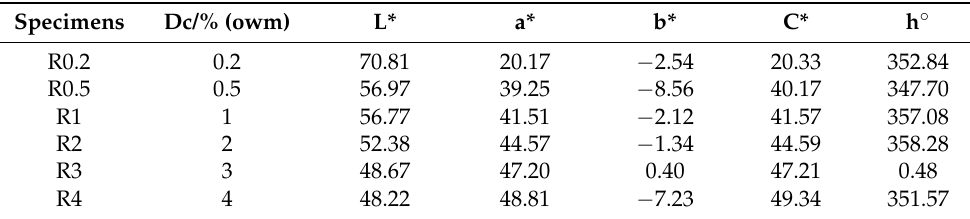
Table 7. Color parameters of specimens dyed with dye Disperse Red 15 (DR15).